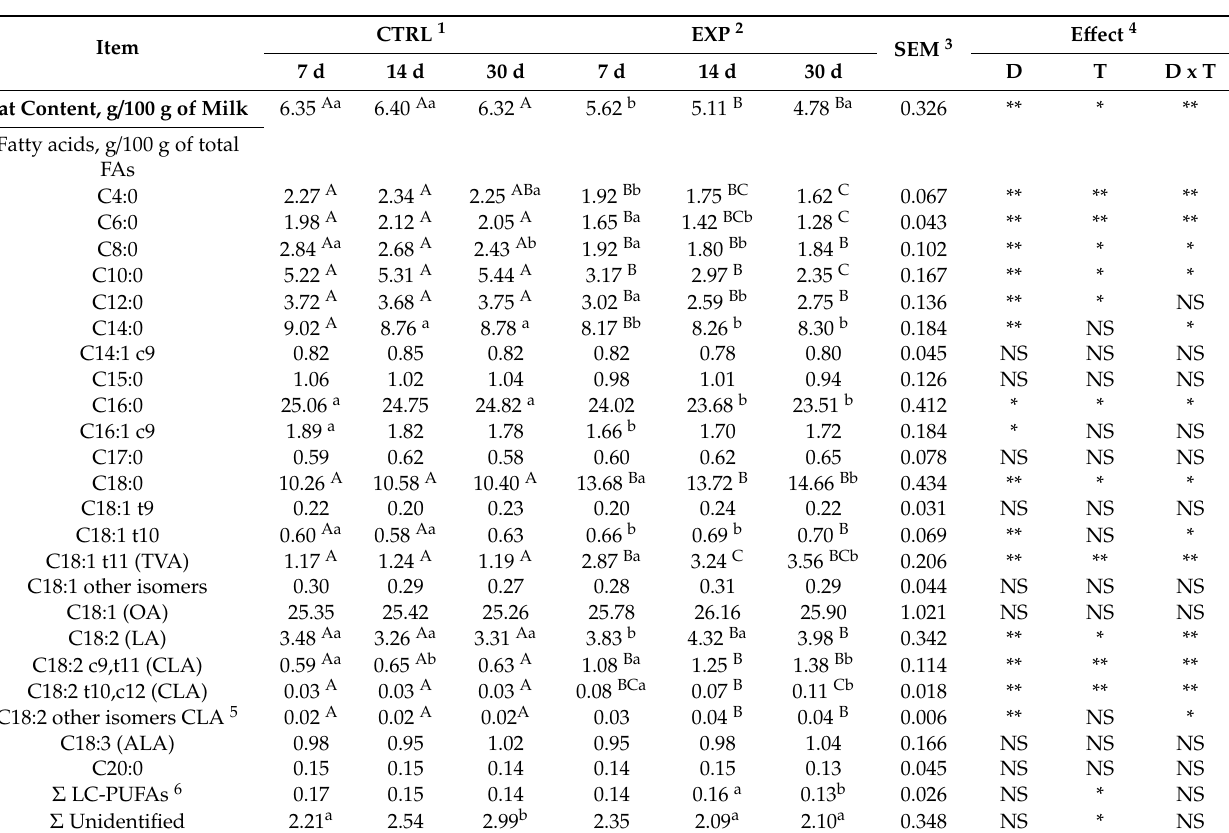
Table 5. ( a ) Means of fat and fatty acid content of total lipids of milk from ewes that were fed the two diets (CTRL and EXP) at the three sampling times (7, 14, and 30 d). ( b ) Means of fatty acid (FA) groups with varying degrees of saturation and carbon chain length, desaturase index, and atherogenic index of milk from ewes that were fed the two diets (CTRL and EXP) at the three sampling times (7, 14, and 30